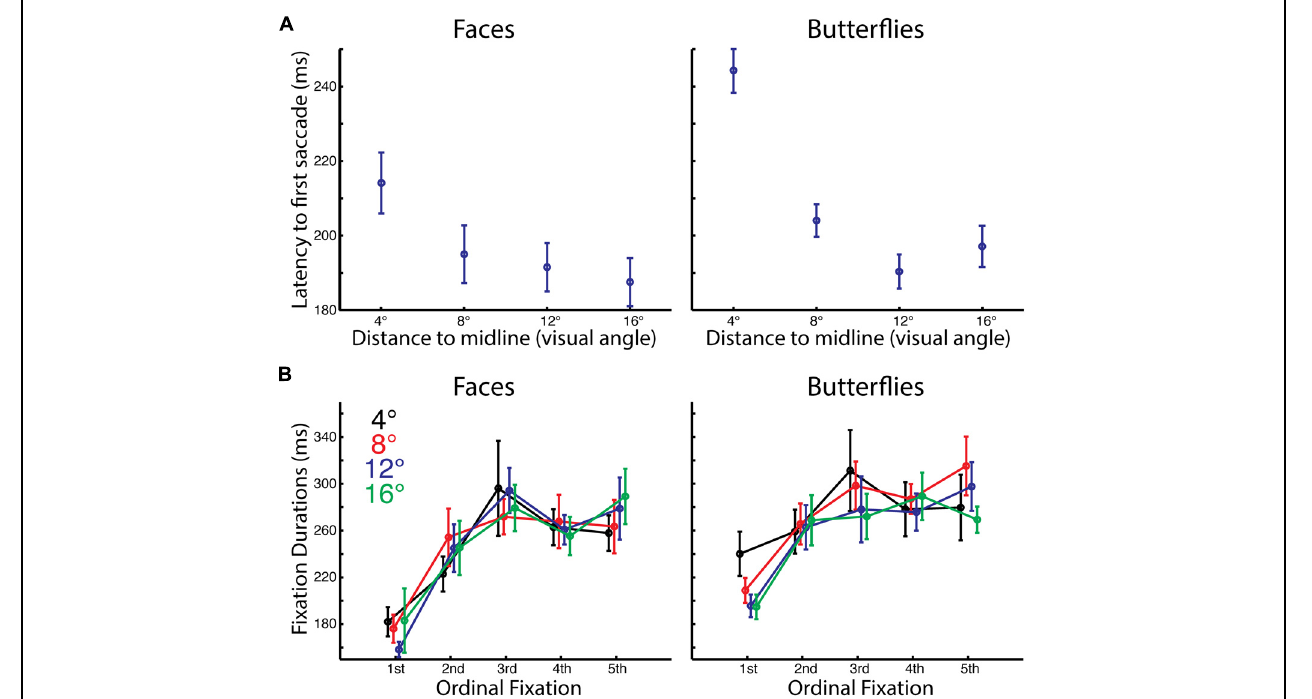
FIGURE 2 | Impact of starting distance on timing of initial saccades and fixations. (A) Average latency to first saccade by starting distance and stimulus category. There was a longer delay between stimulus onset and the first saccade for the 4 ◦ distance compared to farther starting distances. Also there